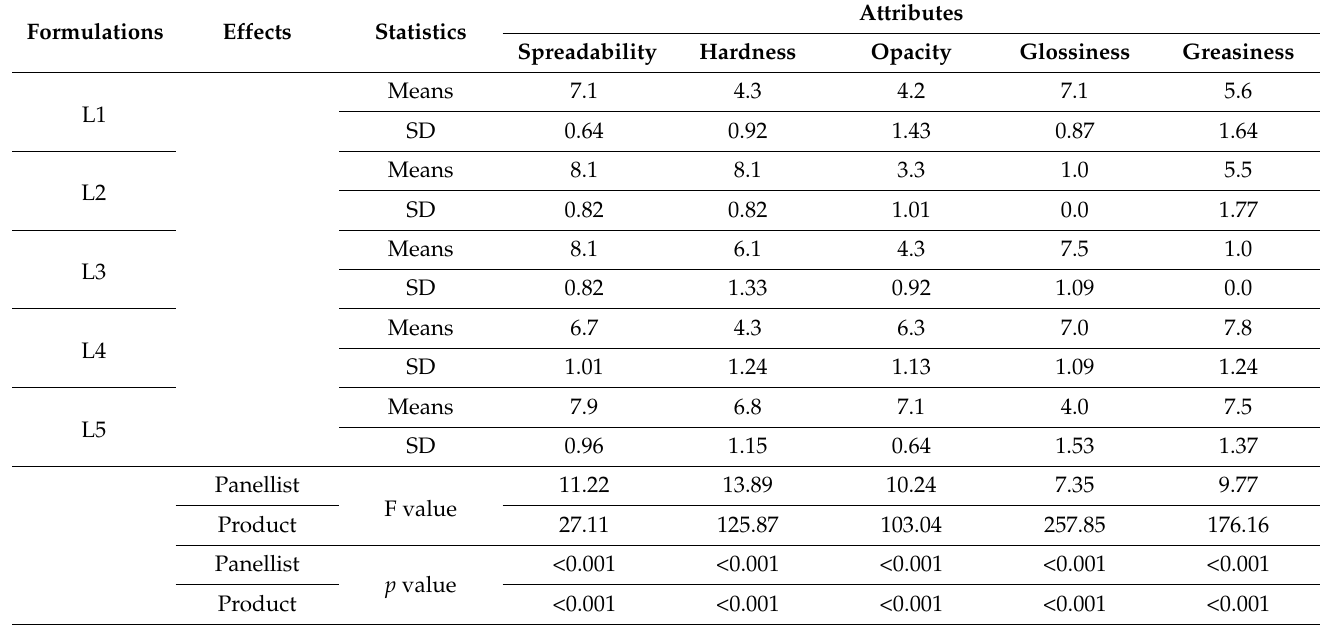
Table 2. Results of two-way ANOVA and Fisher’s LSD test examining the influence of product effects according to panel